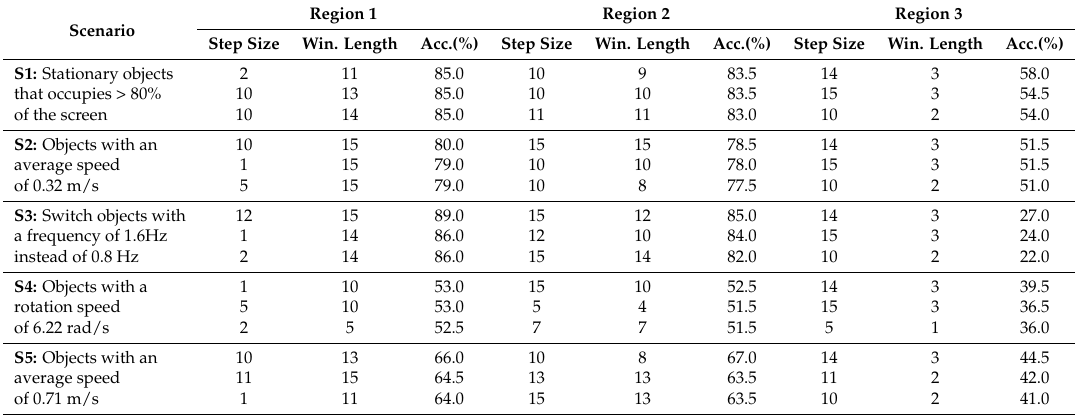
Table 3. Window filter configurations with highest accuracy for each region–scenario pair according to Figure 5 (notation: (cid:96) SS = step size, (cid:96) WL = window length).